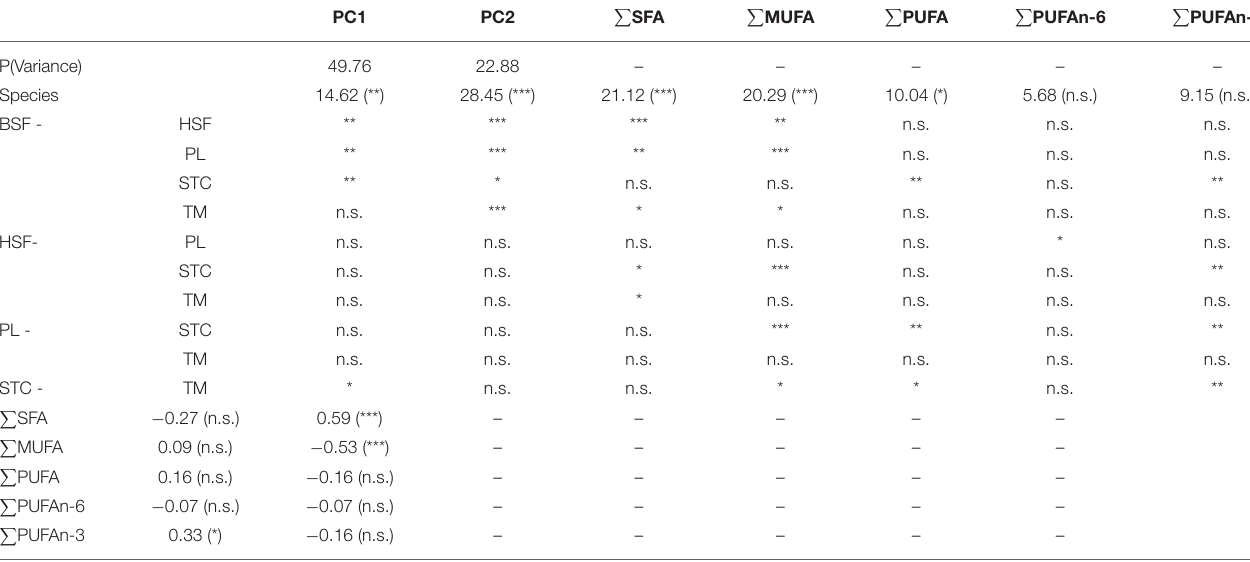
From top to bottom: the proportion of variance in the fatty acid dataset captured by each of the two major principle components in the PCA; Kruskal-Wallis output, in the form χ 2 (significance level), assessing how species differ in their distribution of PC1 and PC2, as well as in their content of each fatty acid saturation class; significance levels of the post-hoc output of the Kruskal-Wallis test, showing which species pairs vary in their principle component distributions and in the degree of saturation of their fatty acid profiles; output of a series of correlation tests, using the Pearson method, assessing the relationship between each fatty acid saturation class and each of the two major principle components in order to